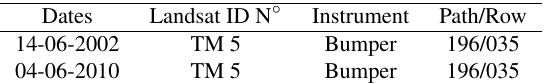
Table 1: Characteristics of the studied